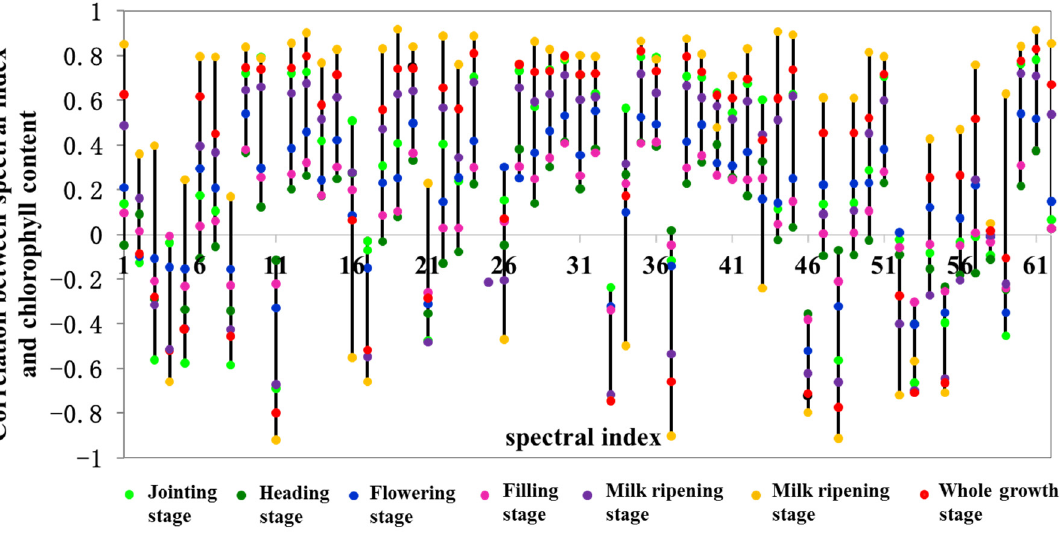
Figure 2. The association between spectral indices and SPAD value at different growth stages.